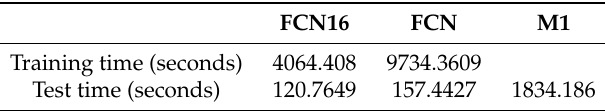
Table 5. Time consumed for training and